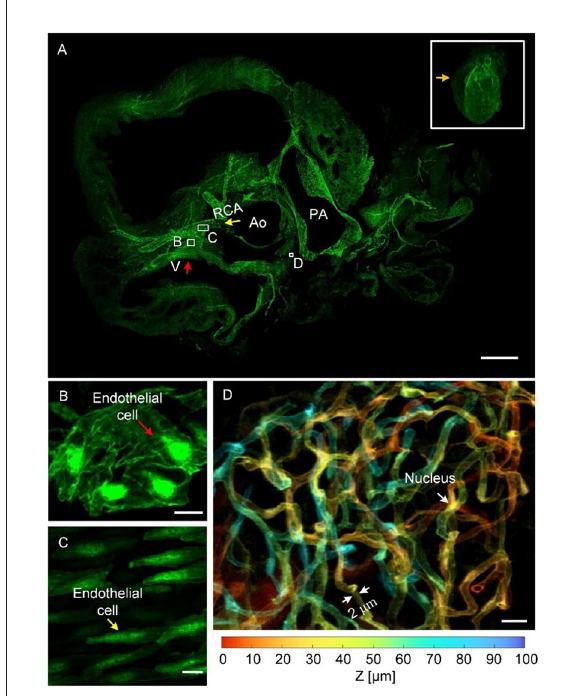
FIGURE3 Images of the whole-heart vascular network at the capillary level. (A) The 3D rendering of whole-heart vascular data (top right) and the MIP generated from raw axial vascular images with a thickness of 300 µ m. V, vein; RCA, right coronary artery; Ao, aorta; PA, pulmonary artery. Scale bar: 500 µ m. (B,C) Scaled images corresponding to the white rectangles in (A) , with an MIP of 100- µ m-thick raw images, displaying endothelial cells in the vein and RCA, respectively. Scale bars: 10 µ m. (D) An enlarged view of the area indicating a depth-coded 100- µ m-thick MIP image (A) , showing a partial capillary network with depth information. Scale bar: 10 µ m.